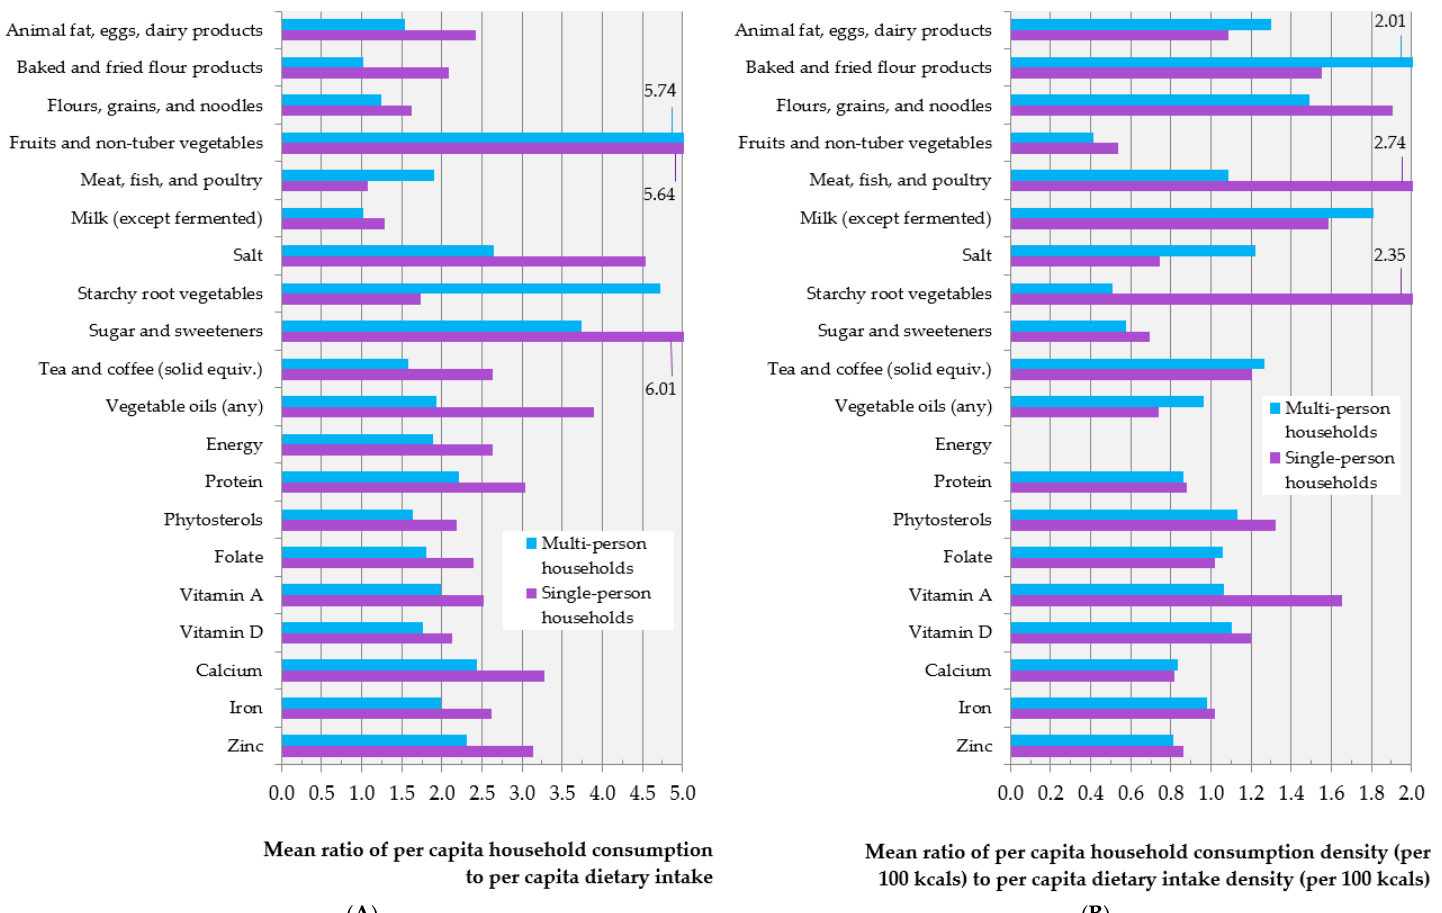
Figure 2. Mean ratio of per-capita household consumption to per-capita dietary intake ( A ), and per-capita household consumption density (per 100 kcal) to per-capita dietary intake density (per 100 kcal); ( B ) for food groups and selected nutrients among 109 FCS-HH households fully-enumerated by the nested FCS-24 (Aim 1). Values for 6 data points exceed the graphs’ x-axis limits and are indicated using annotations. Abbreviations: FCS-HH (2013 Food Consumption Survey), FCS-24 (nested 24-h recall).